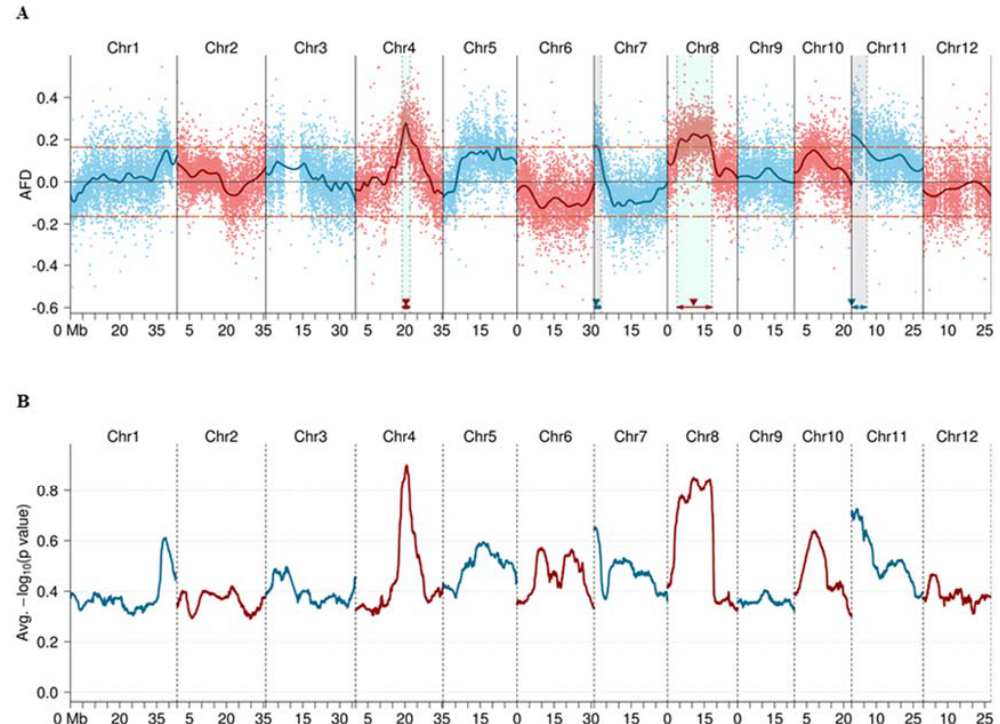
Figure 2. BSA-seq-based identification of four candidate quantitative trait loci (QTLs) conferring basal resistance to rice blast disease. ( A ) Allele frequency di ff erence (AFD) graph from BSA-seq analysis. The horizontal orange dashed lines indicate the threshold ( ± 0.165) at the overall significance level of p < 0.05. QTL positions estimated are indicated by filled triangles. AFD was obtained by subtraction of allele frequency (AF) of the extremely susceptible (ES) pool from that of the extremely resistant (ER) pool. ( B ) T -test verification for the two replicated sub-pools for the ER pool and the ES pool. The average negative logarithmic p -values of the markers were smoothed by sliding window (size = 3000 kb and step = 10 kb) across each chromosome. The peaks of the p -value graph were consistent with those in the AFD